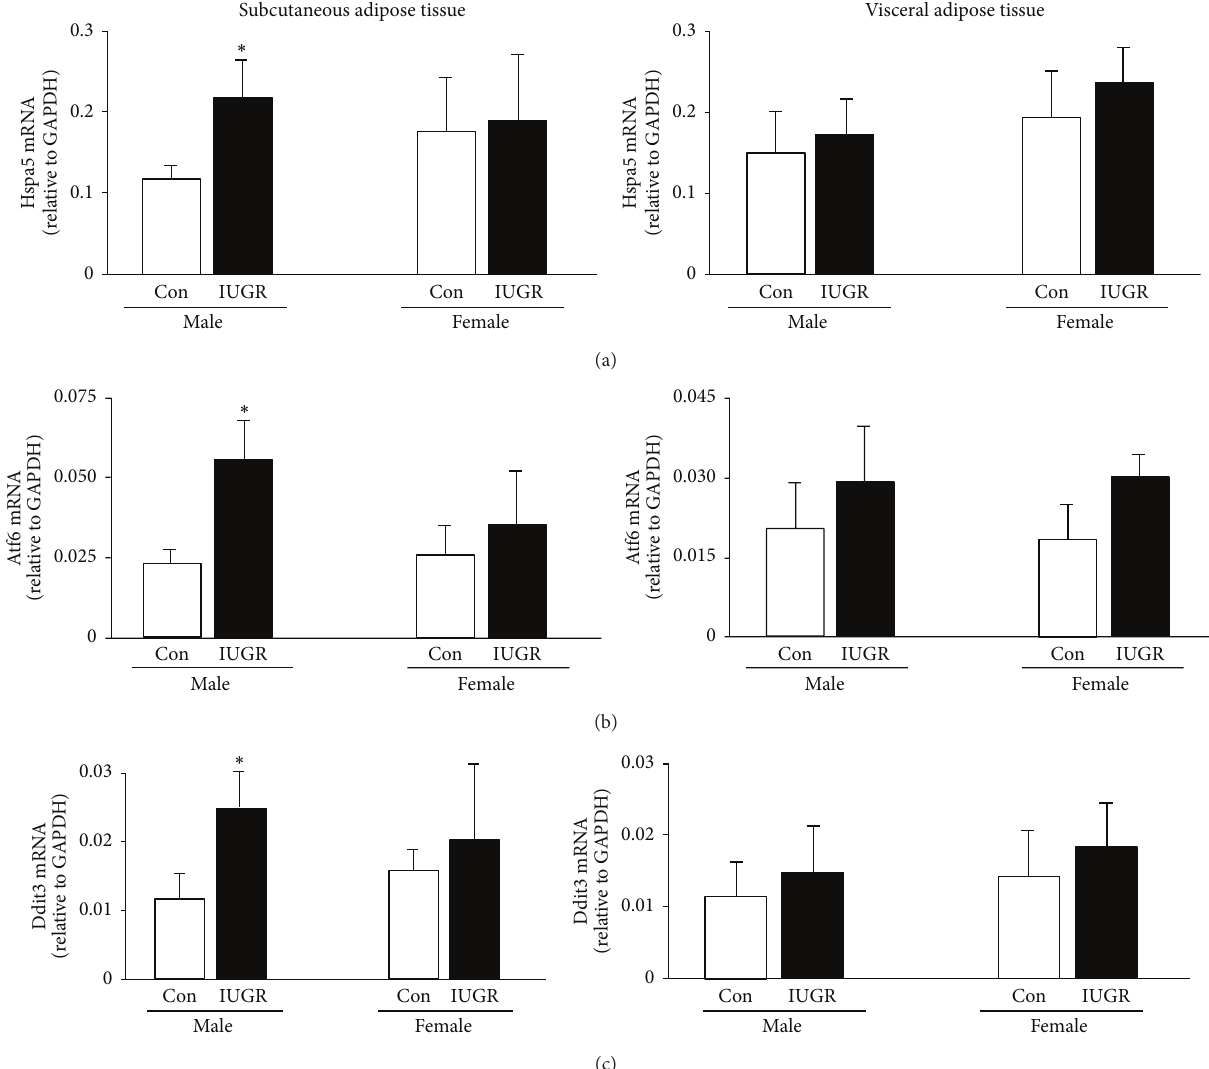
Figure 4: UPR mRNA levels. IUGR increases subcutaneous Hspa5, Atf6, and Ddit3 mRNA levels in male rats. Errors are SD. 𝑛 = 6 , ∗ 𝑃 ≤ 0.05 . Subcutaneous adipose tissue